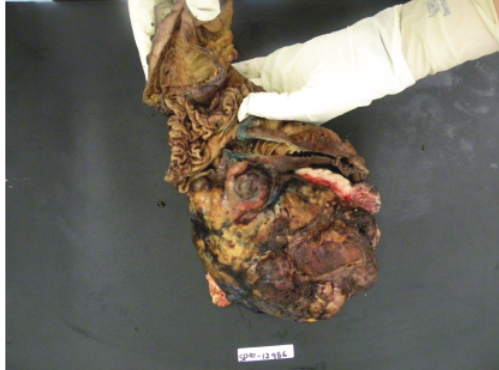
Figure 2: En bloc hemicolectomy specimen, showing cecum and terminal ileum with overlying tumour. Arrow points to part of the appendix wall.